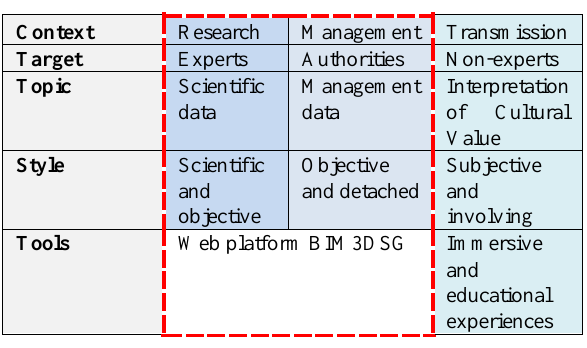
Table 1. According to the target and the context of communication, the style and the tools change. In dashed lines, the focus area of the article. Source: re-elaboration from Negrini,